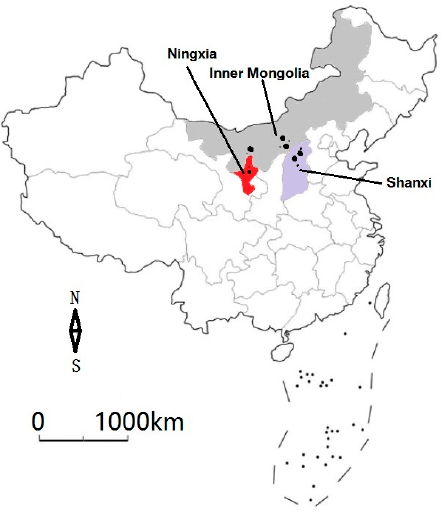
Figure 1. Location of the high-aluminum coalfields in northern China.